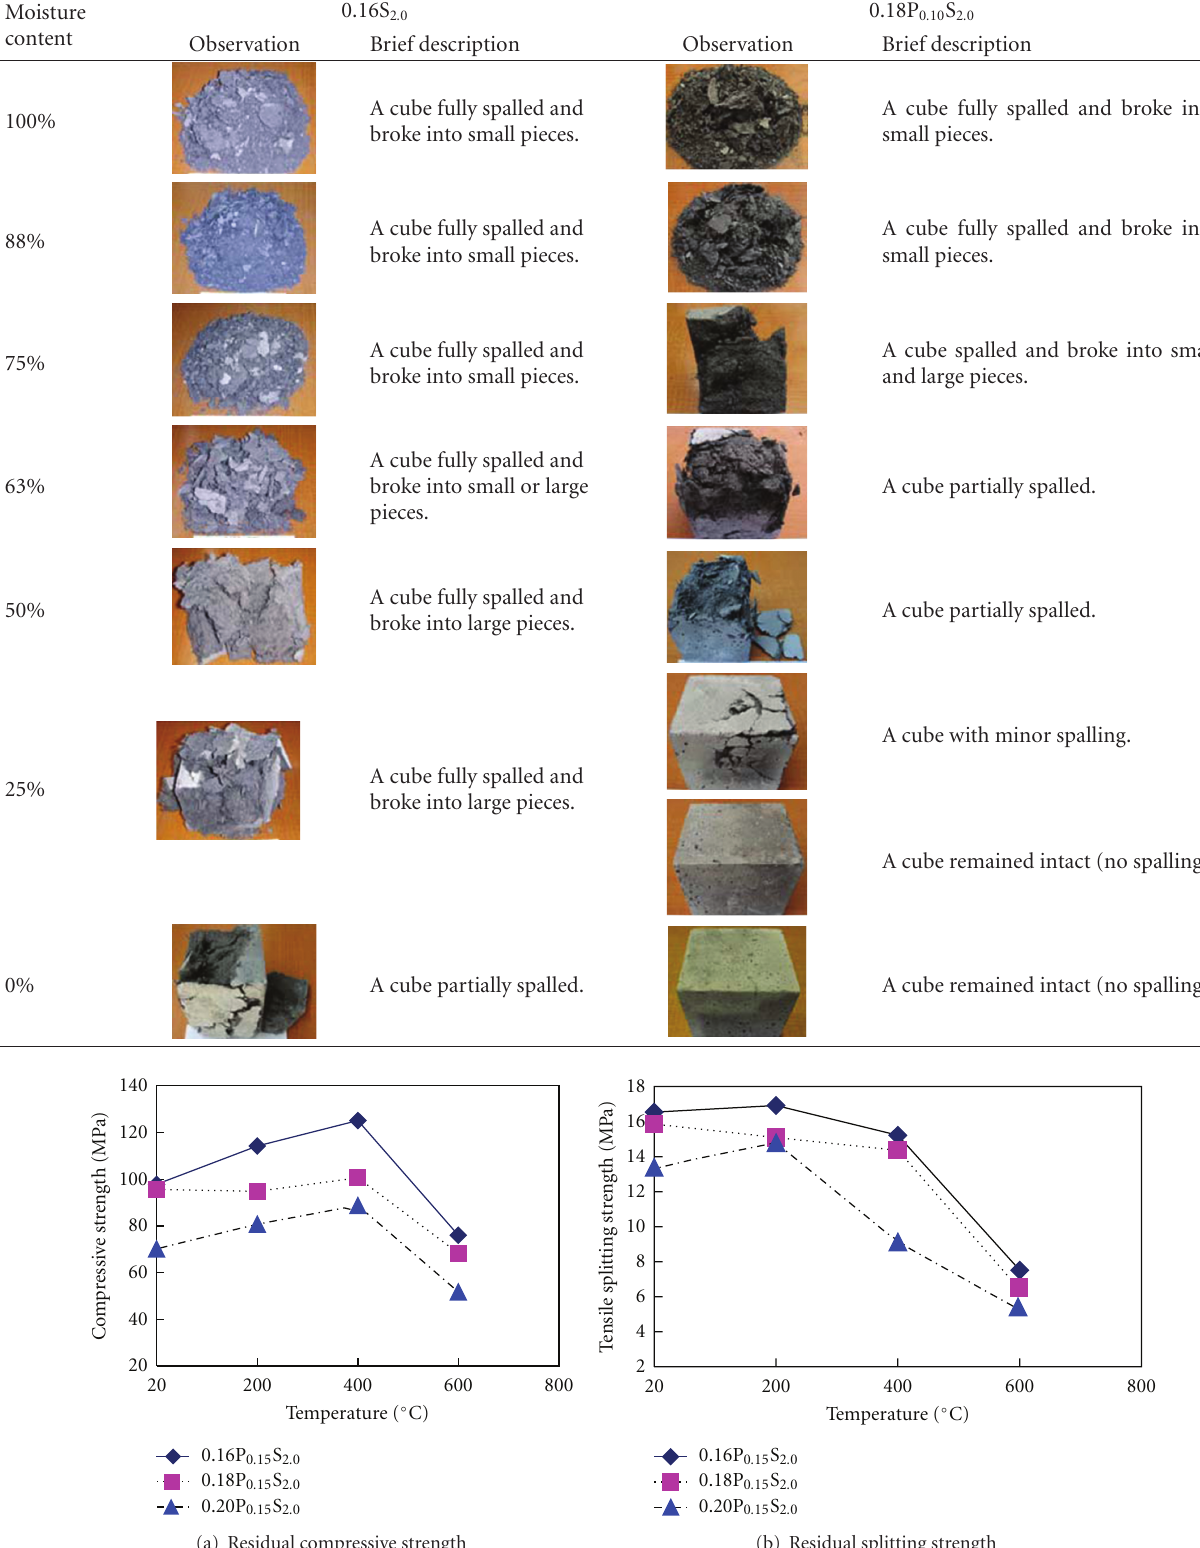
Table 3: Observations of two types of RPC with various moisture contents after spalling tests.